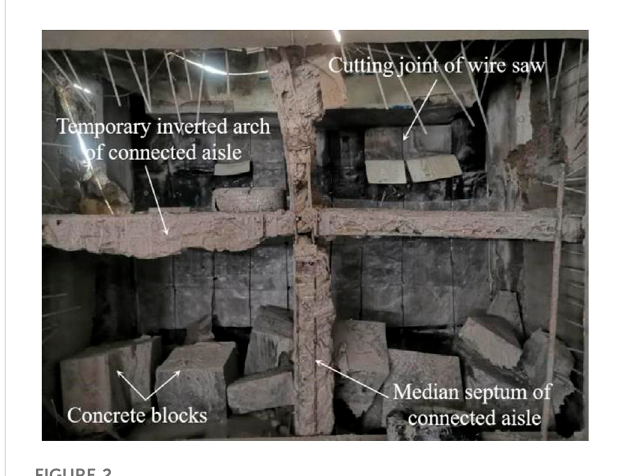
FIGURE 2 The construction site of opening